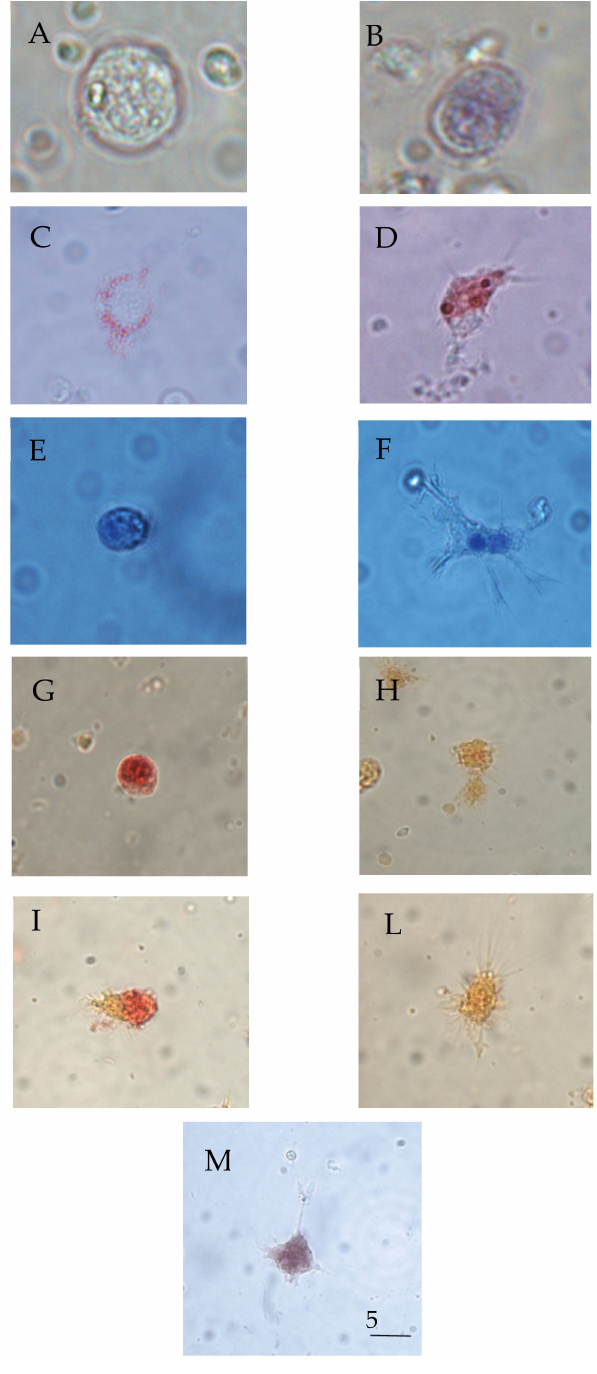
Figure 3. Light micrographs of R. philippinarum haemocytes following exposure to C6O4. ( A , B ) Unfixed cells stained with Trypan Blue (live cell in ( A ), dead cell in ( B )). ( C , D ) Haemocytes vitally stained with Neutral Red (intact cell with evident lysosomes in ( C ), damage cell showing dye loss into the cytosol in ( D )). ( E , F ) Haemocytes stained with Giemsa’s dye (round cell in ( E ), spreading cell in ( F )). ( G ) Haemocyte positive to acid phosphatase. ( H ) Haemocyte not positive to acid phosphatase. ( I ) Haemocyte positive to β -glucuronidase. ( L ) Haemocyte not positive to β -glucuronidase. ( M ) Haemocyte with deposits of formazan (blue) after solubilisation with KOH/DMSO solution. Bar length: 5 µ